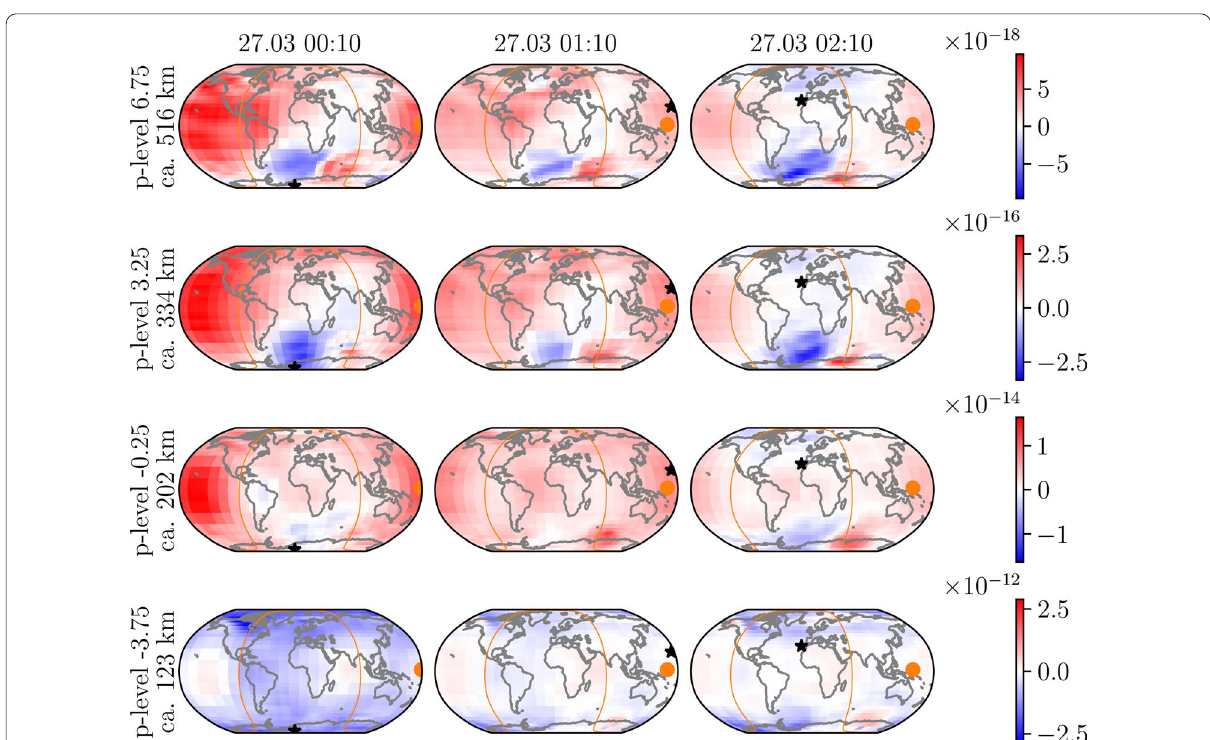
Fig. 10 Each map corresponds to a pressure level of the state grid . The difference between the forecast mean and analysis mean of the neutral density (cid:31) g cm 3 (cid:30) is indicated by the color bars on the right. Each row corresponds to a pressure level. each column to an analysis step. This figure shows the three first analysis steps. The horizontal position of CHAMP is marked with a black star, the position of the Sun with an orange circle, and the day–night border with an orange